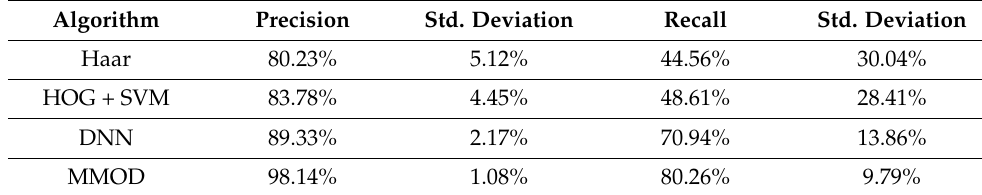
Table 1. Accuracy comparison of four different methods in face detection.